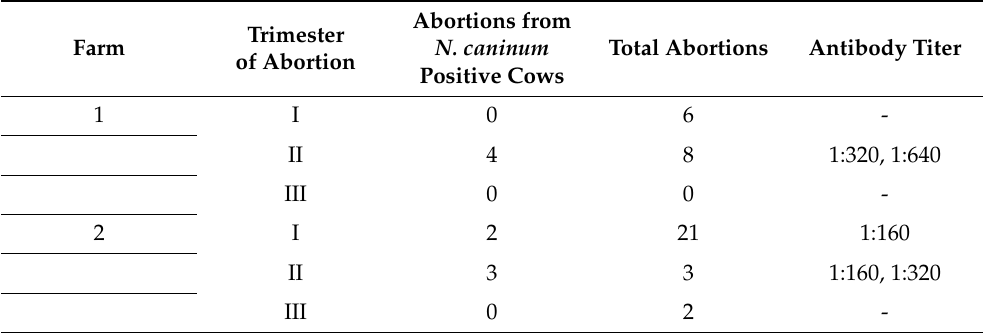
Table 3. Episodes of abortion occurring in the study farms between January 2017 and April 2018. Antibody titer of seropositive aborting cows is also reported. Abortions from Trimester N. caninum Total Abortions Antibody Titer Farm of Abortion Positive Cows 1 I 0 6 - II 4